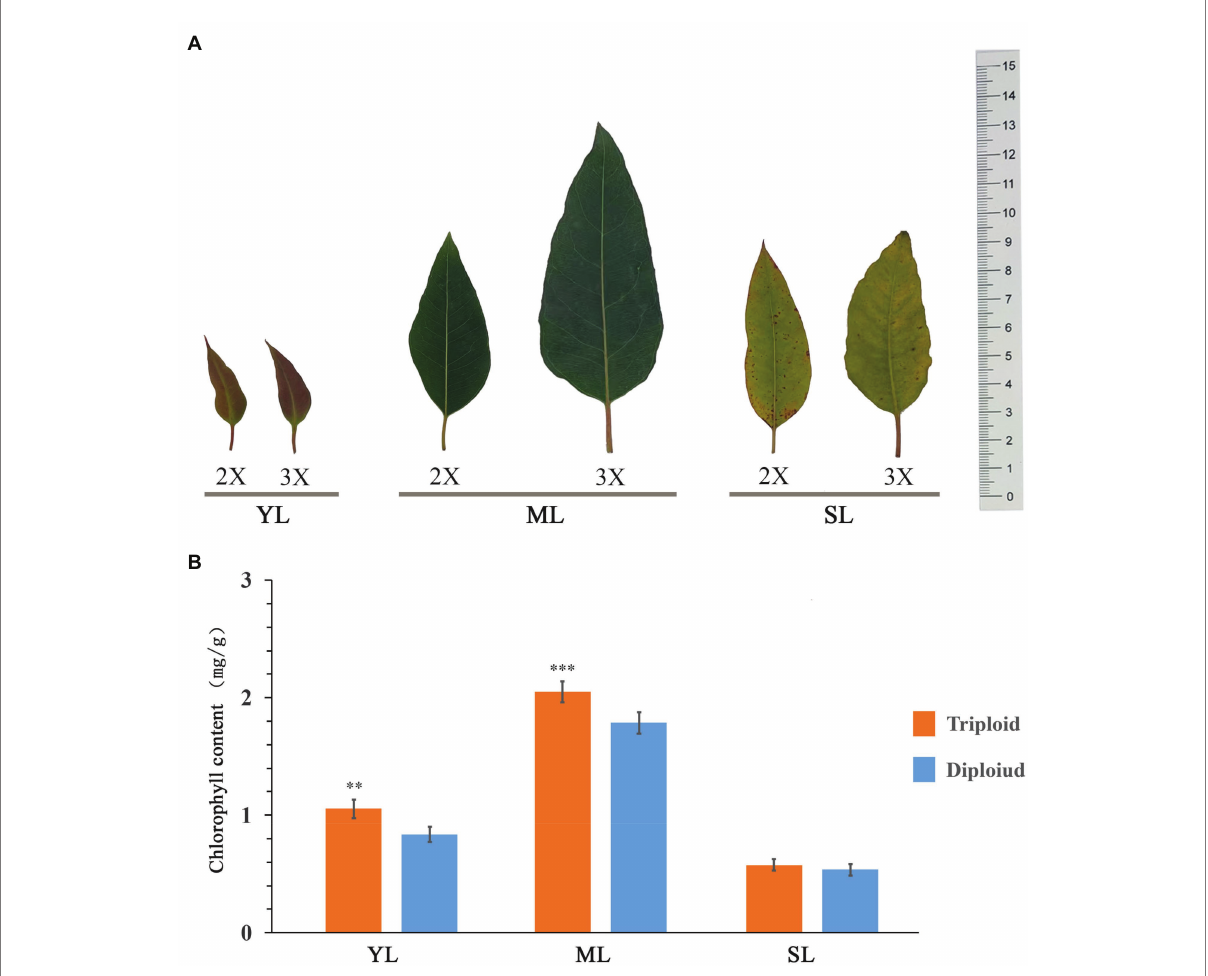
FIGURE 6 Measurement of chlorophyll content in leaves of E. urophylla . Phenotype (A) and chlorophyll content (B) of young leaves (YL), mature leaves (ML), and senescent leaves (SL) of diploid (2X) and triploid (3X)